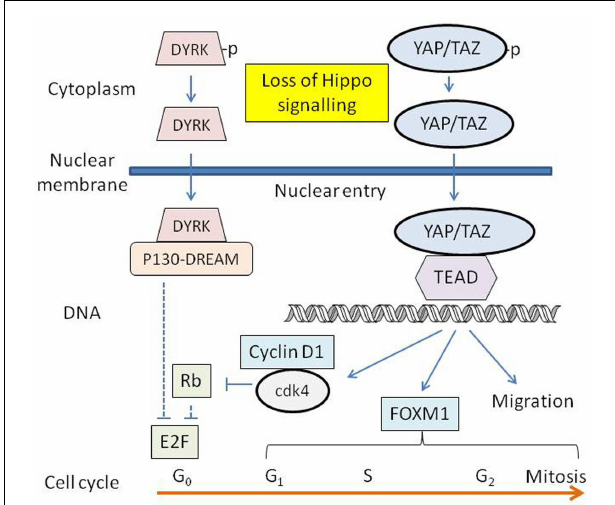
FIGURE 4 | Diagram showing some of the downstream elements of the proposed Hippo pathway .The transcription factorsYAP/TAZ-TEAD are activated, and DYRK-DREAM is inactivated by loss of Hippo signalling. Resulting transcription products are involved in regulating the synthesis of a number of proteins associated with cell proliferation and migration.